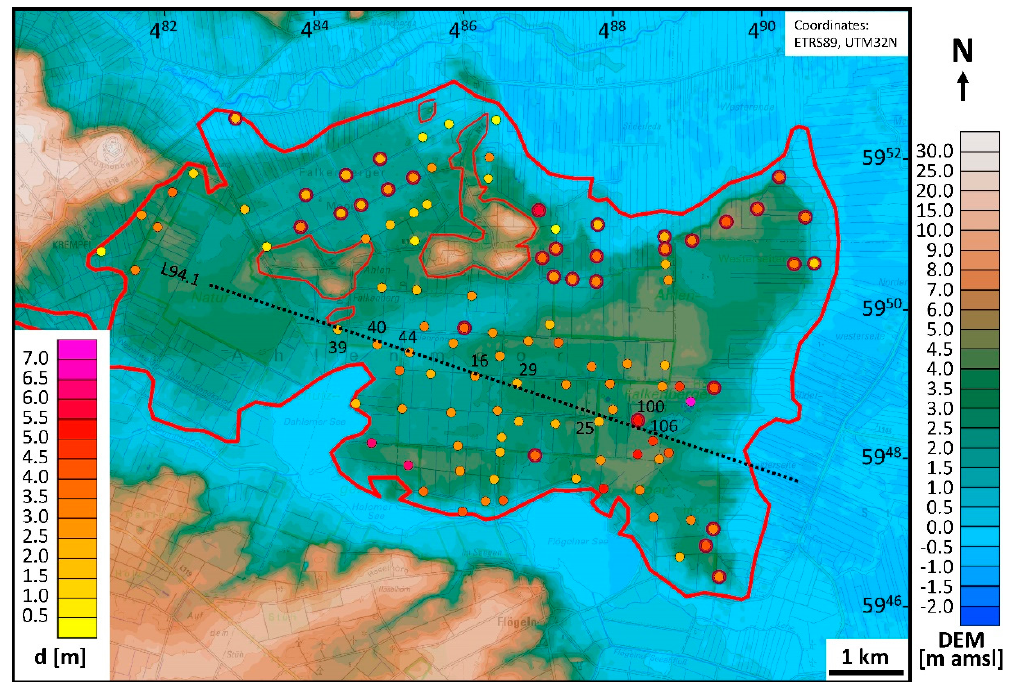
Figure 4. Digital elevation model DGM25 [19]. The thick red line outlines the bog and the thin red lines display the location of Geest highs inside the bog area [15]. The colored dots show the location of boreholes and indicate peat thicknesses above sandy (smaller dots) or clayey (larger red-rimmed dots) soil sediments found in 110 boreholes [20]. The dotted line indicates a flight line (L94.1) close to selected boreholes (numbers). Background: DTK50-V [22].